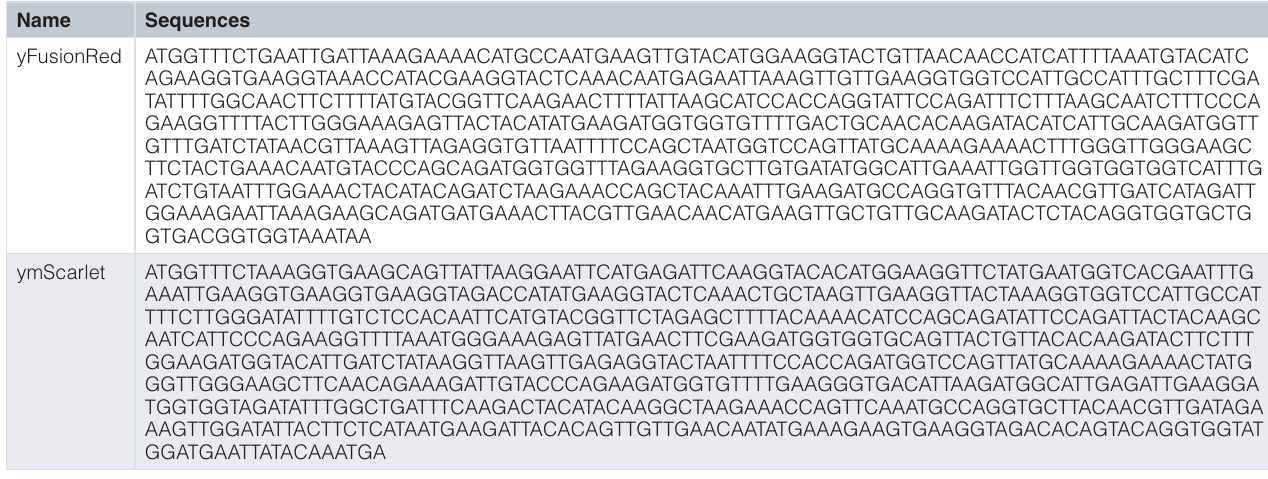
Table 2. Sequences of yeast optimized fluorescent proteins generated in this